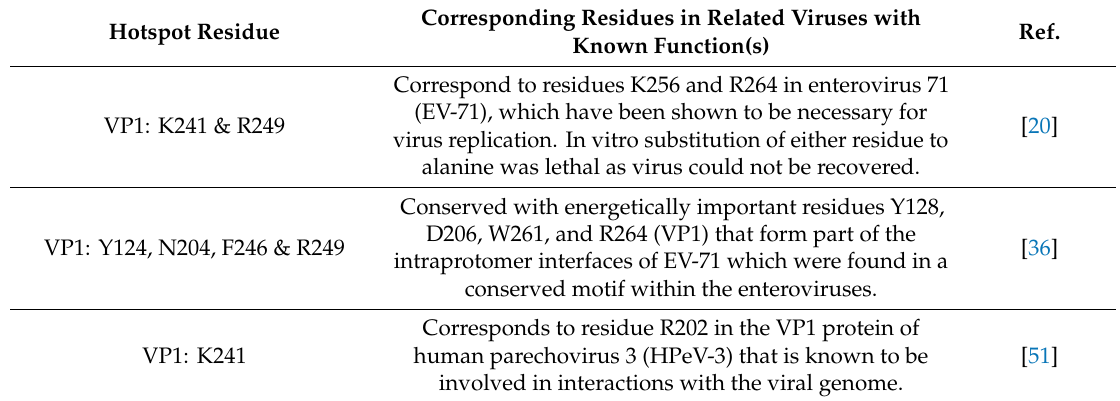
Table 4. Intraprotomer hotspot residues in TMEV conserved with residues in related viruses with previously identified roles.